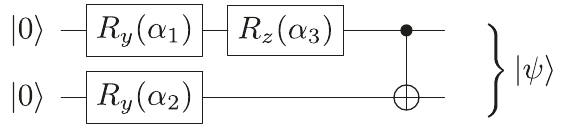
Fig. 4 Circuit for experiments on IBMQ. This parameterized two- qubit quantum circuit U ( α ) is used for preparing the test state ψ AB ( α ) on the ibmq-santiago hardware. The parameters α are randomly initialized as ( α 1 , α 2 , α 3 ) = (3.2292, 4.8579, 5.4691).